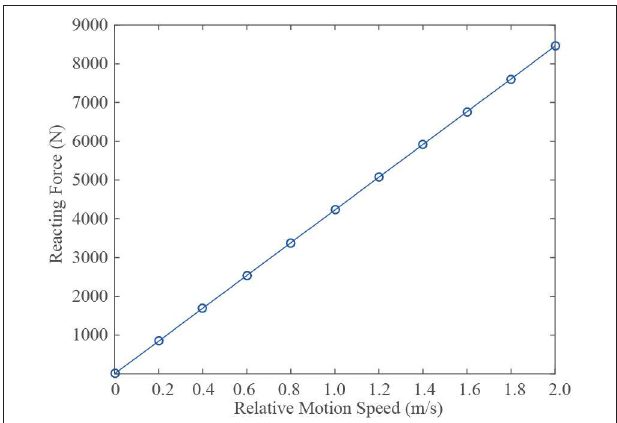
FIGURE 2 | The reacting force vs. the relative motion speed of the PTO system.